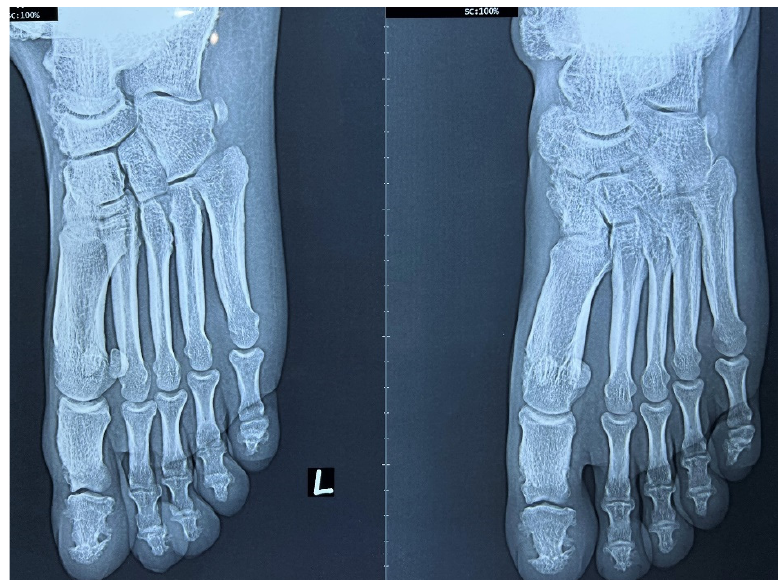
Figure 7. X ray of the feet (2022) showing that the periostal hypertrophy and calcifications had disappeared, but that the soft tissue around the distal phalanges was still swollen.